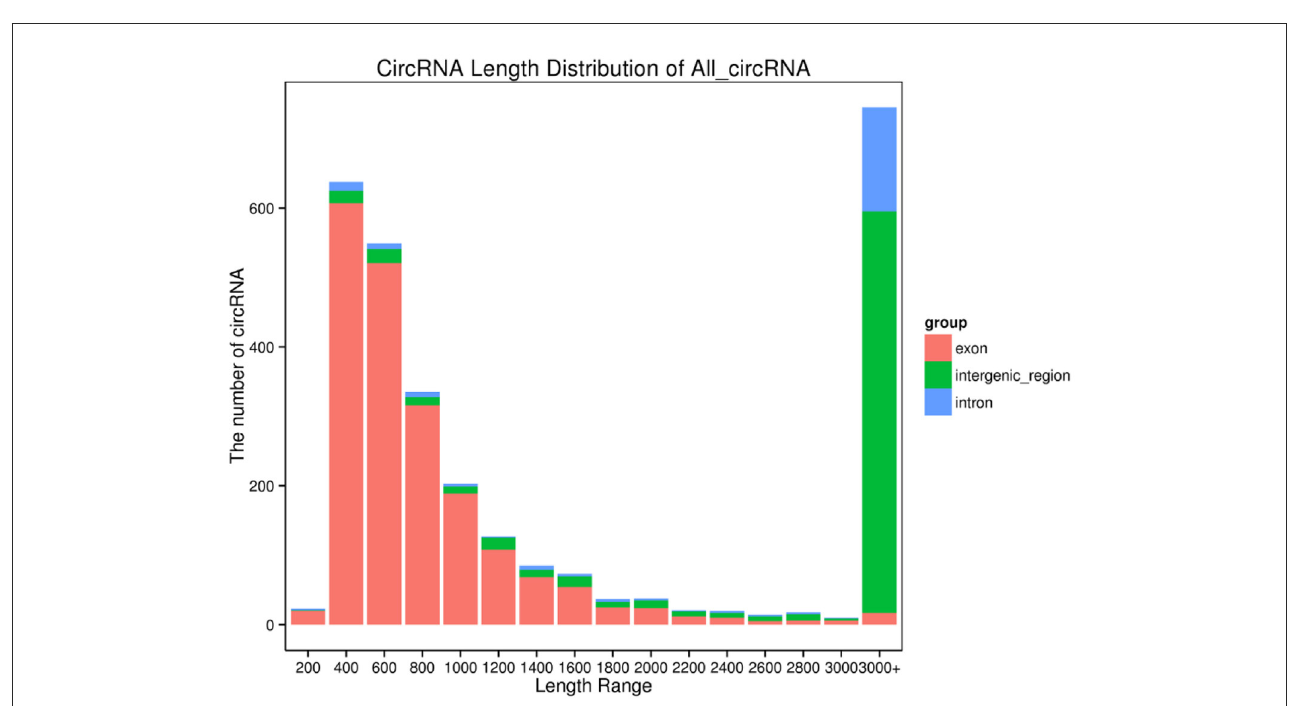
FIGURE4 CircRNA length distribution. Abscissa, length interval; Ordinate, the number of circular RNAs in the length interval.